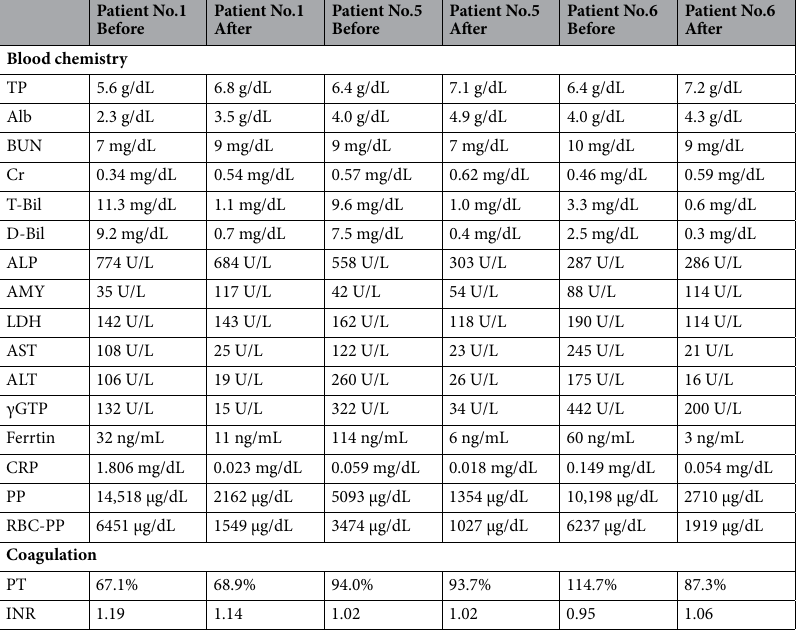
Table 4. Laboratory data immediately before and after phlebotomy. TP total protein, Alb albumin, BUN blood urea nitrogen, Cr creatinine, T-Bil total bilirubin, D-Bil direct bilirubin, ALP alkaline phosphatase, AMY amylase, LDH lactate dehydrogenase, AST aspartate aminotransferase, ALT alanine aminotransferase, γGTP γ-glutamyl transpeptidase, CRP C-reactive protein, PP protoporphyrin, PT prothrombin time, INR international normalized